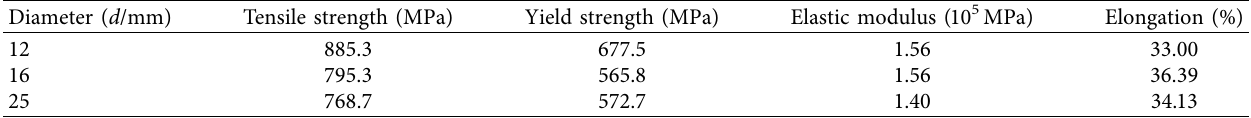
Table 2: Mechanical indexes of stainless steels.